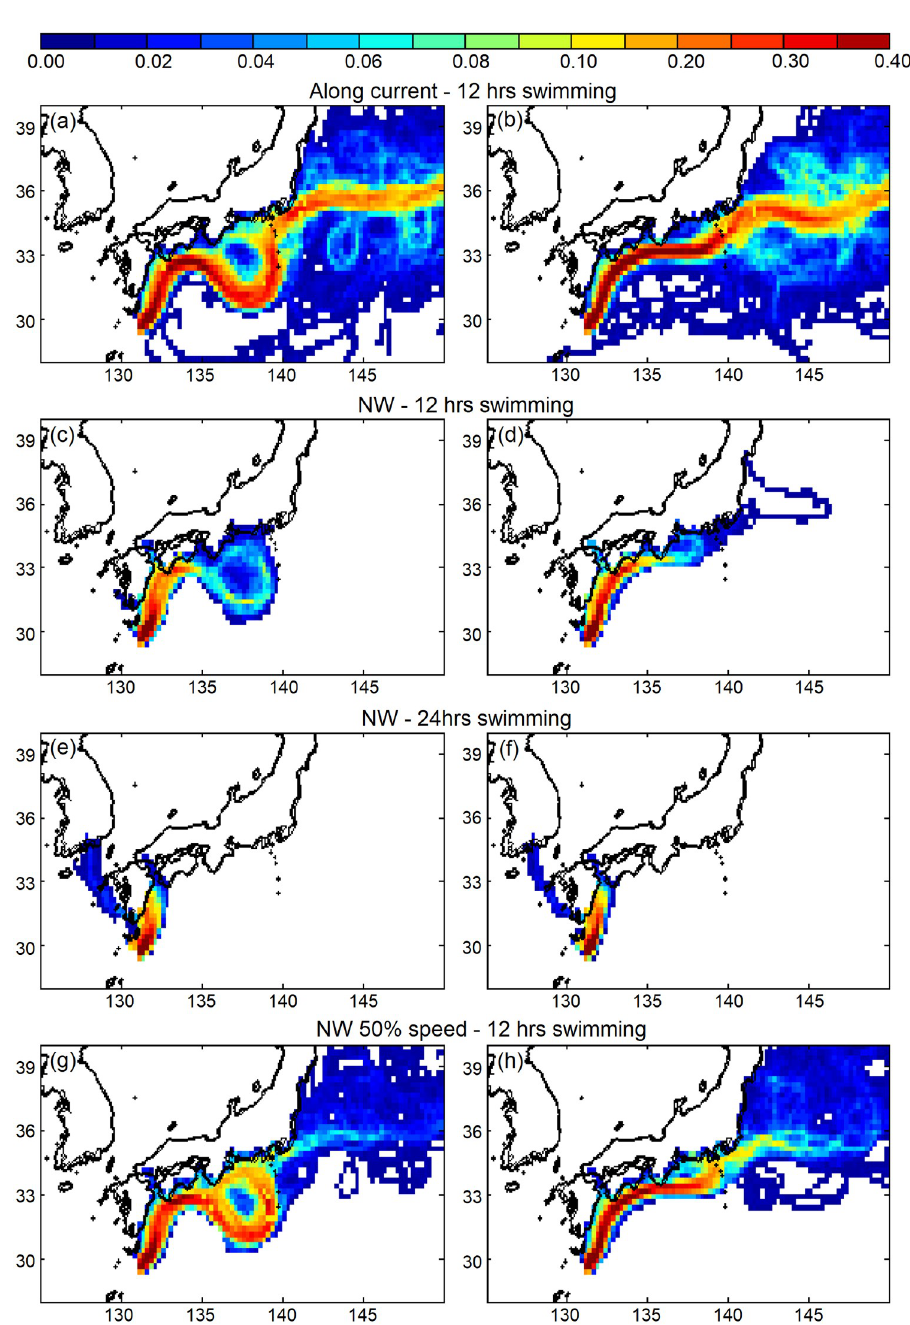
Fig 5. Visitation frequency of v-larvae released within the Kuroshio south of Japan in the large meander years (2005 and 2018, left) and non-large meander years (2010 and 2016, right) with different swimming strategies at the end of the recruitment season: Along current (a, b), northwestward swimming (c, d), 24-hour northwestward swimming (e, f), and half speed northwestward swimming (g, h).